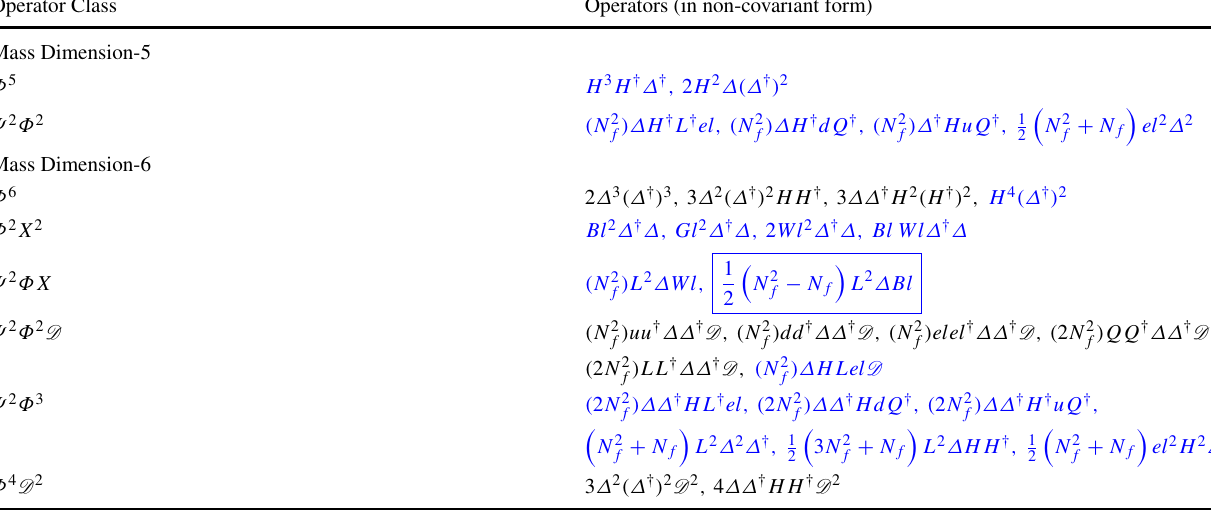
Table 33 SM + complex triplet scalar( Δ ): operators of mass dimensions-5 and -6 excluding pure SM operators